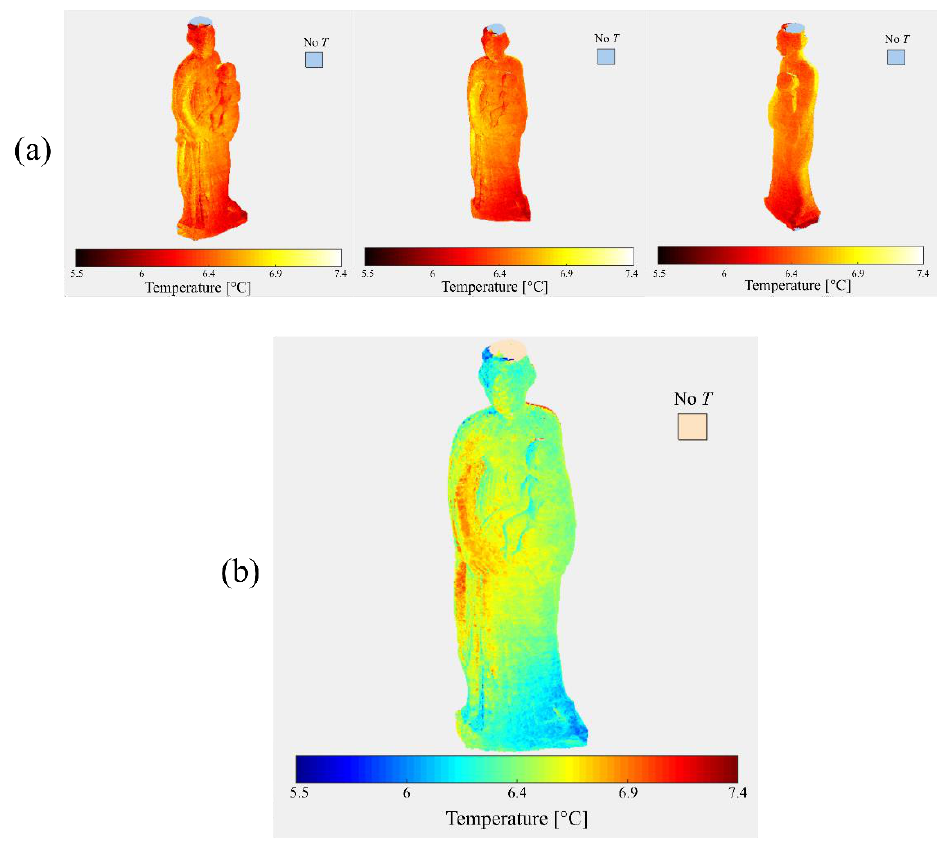
Figure 17. Results of the integration of twelve thermograms. ( a ) Three different views coloured with the colormap “hot”. ( b ) Frontal view coloured with the colormap “jet”.